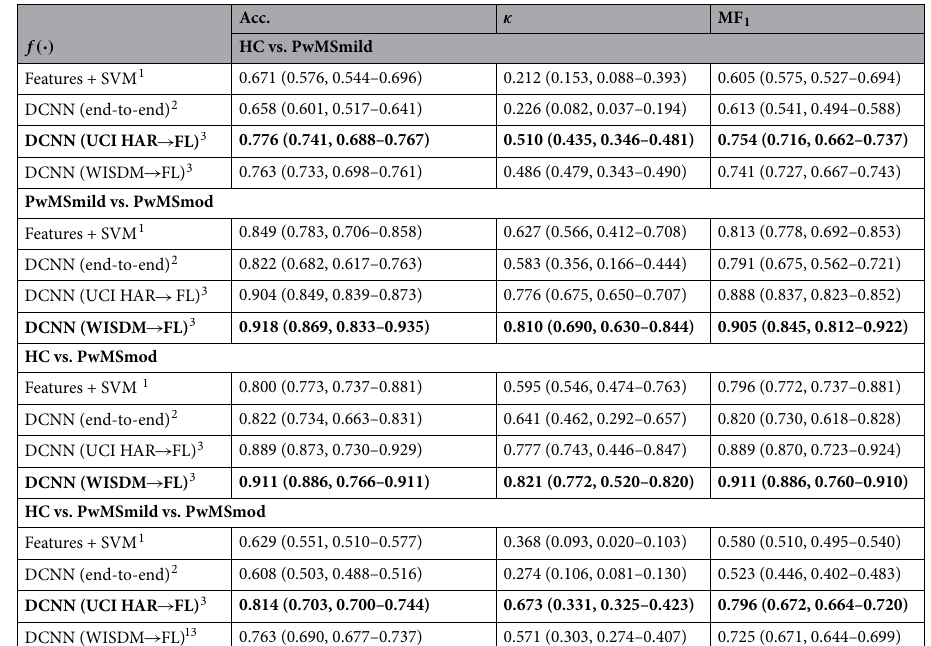
Table 2. Comparison of HC vs. PwMS subgroup classification results between various models for each task subset, T . Results are presented as: (1) the posterior overall subject-wise outcome for one cross-validation (CV) run as well as (2) the 2MWT test-wise median and interquartile range (IQR) across that CV in brackets. The best performing model for each T are highlighted in bold . Acc: Accuracy; κ , Cohen’s Kappa statistic; 1 MF 1 , Macro-F1 score. “features + SVM” refers to classification performed using features and a SVM with the 2 pipeline described in 3 ; “end-to-end”, refers to a model trained and validated end-to-end exclusively on D T 3 data; “ → ” denotes the source HAR dataset D S used and transferred to FL D S and T S . See Fig. 6 for a more detailed description of the TL approach used in this